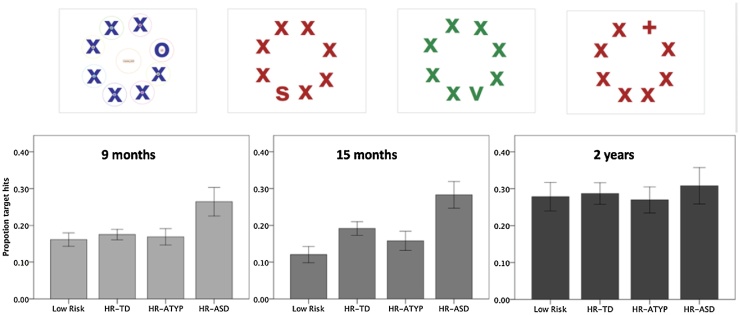
Proportion of correct first looks, at 9 months, 15 months and 2 years. Bars represent 1 SE.